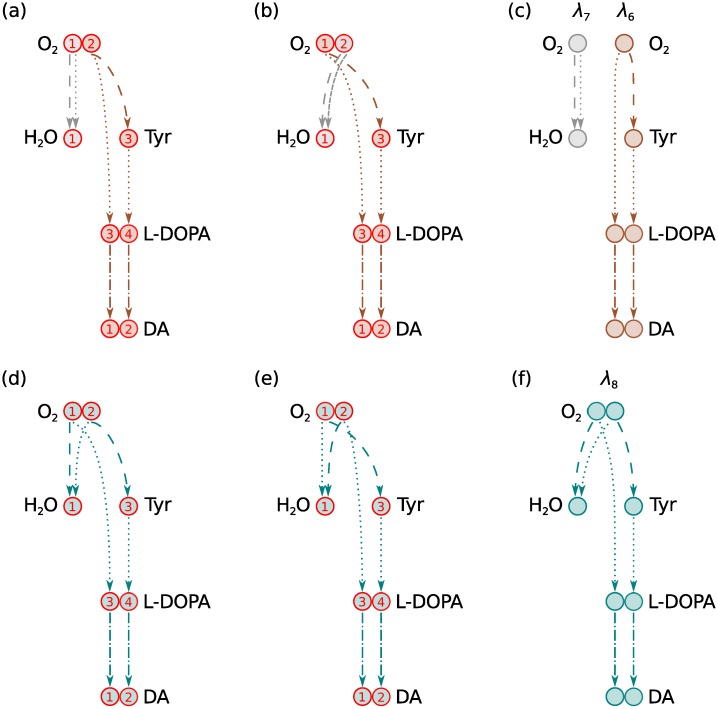
Effects of variable atom mappings between O2 and H2O in DAS.The recurring metabolite pair exchanges an oxygen atom in two reactions, R1 and R2 in Fig 4. Since the two oxygen atoms of O2 are symmetric, there are four possible combinations of oxygen atom mappings for these two reactions. Each combination gives rise to a different oxygen transition network. (a) The first oxygen atom (O1) in O2 maps to the single oxygen atom (O1) in H2O in both R1 and R2. (b) O2 in O2 maps to O1 in H2O in both R1 and R2. (c) Moiety graphs obtained from the oxygen atom transition networks in (a) and (b). Two nondecomposable moiety conservation relations were identified in each atom transition network where the same atom mapped from O2 to H2O in both R1 and R2. (d) O1 in O2 maps to O1 in H2O in R1 while O2 in O2 maps to O1 in H2O in R2. (e) O2 in O2 maps to O1 in H2O in R1 while O1 in O2 maps to O1 in H2O in R2. (f) The single moiety graph obtained from the oxygen atom transition networks in (d) and (e). Only one composite moiety conservation relation was identified in each atom transition network where a different atom mapped from O2 to H2O in R1 than R2.